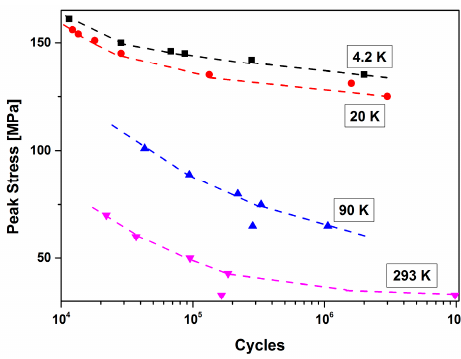
Figure 4. Peak stress against number of cycles before fracture at 4.2, 20, 90, and 293 K (redrawn from Figure 88 in [19]).